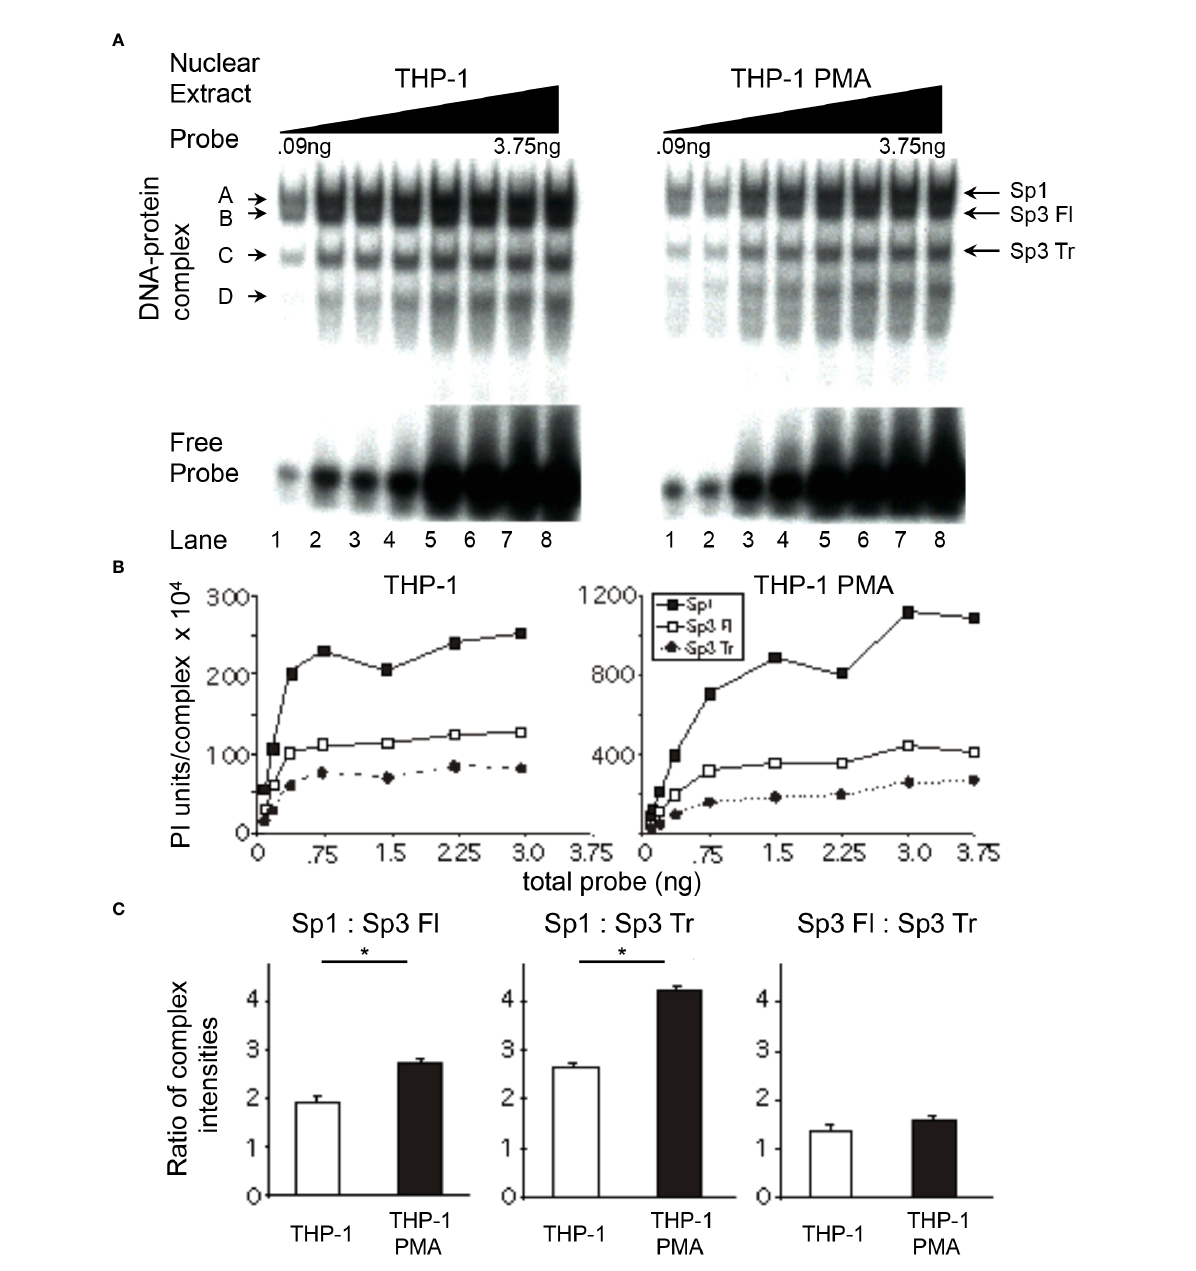
FIGURE 5 Relative levels of Sp factor binding in the monoblastic THP-1 cell line varies with the addition of the chemical differentiating agent, PMA. Relative Sp factor binding was examined by EMS probe titration analyses. (A) Untreated and PMA-treated THP-1 nuclear extracts (6 m g) were reacted with increasing amounts of labeled HIV-1 Sp site III probe (12,500 to 500,000 cpm; 0.09 to 3.75 ng). Complexes were separated by a 2-hr electrophoresis interval utilizing 4% acrylamide gel to retain unbound probe to facilitate subsequent analysis. DNA-protein complexes are labeled A through D; arrows indicate the position of low mobility Sp-related complexes. Representative image shown. (B) Untreated and PMA-treated THP-1 nuclear extracts (6 m g) were reacted with increasing amounts of labeled HIV-1 Sp site III probe (12,500 to 500,000 cpm; 0.09 to 3.75 ng). Complexes were subjected to a 3-hr electrophoresis interval utilizing 4% acrylamide to allow for greater separation and a more accurate subsequent quantitation of the DNA-protein complexes. Unbound probe was not retained. DNA-protein complexes were quantitated and graphed as phosphorimager units per complex. Representative graph shown. (C) DNA-protein complexes intensities (B) were averaged at plateau and their relative levels compared within a given gel. This process was repeated three times and the average of the three relative intensities was graphed for each pair of DNA-protein complexes examined: Sp1 relative to full-length Sp3, Sp1 relative to Sp3 Tr, and Sp3 Fl relative to Sp3 Tr. Comparisons between all were evaluated by the quantitative two-tailed student t-test and p < 0.05 was considered signi fi cant